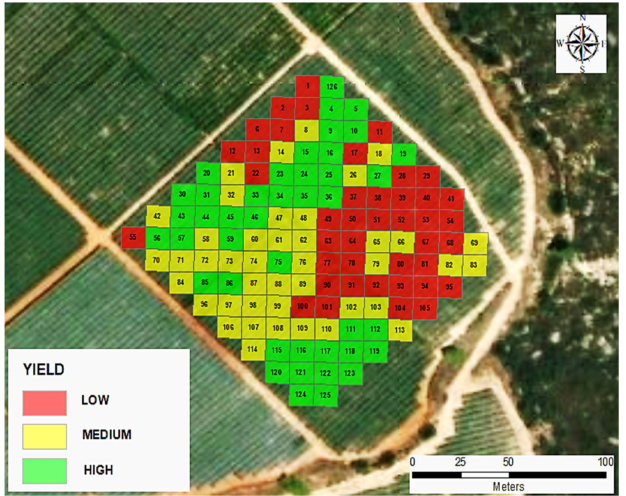
Figure 9. Yield map showing the spatial distribution of the grape production classified into three classes (low, medium, and